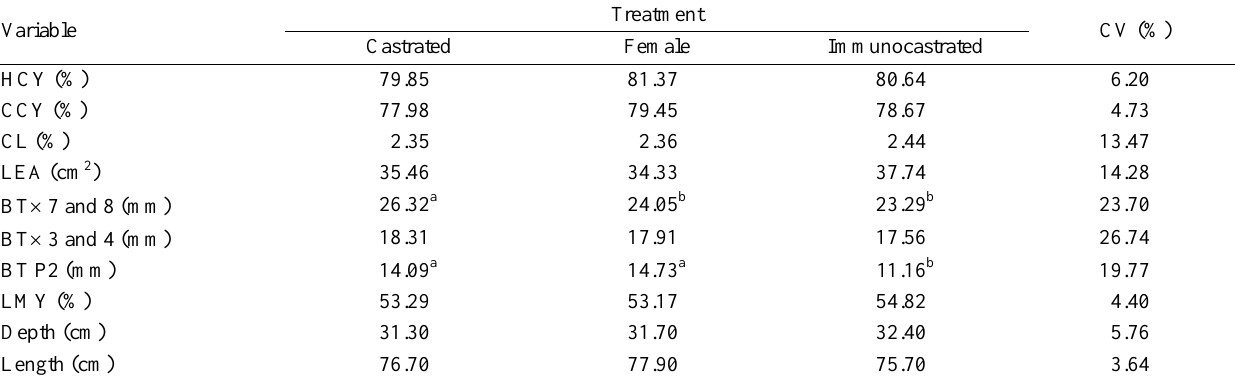
Table 2. Hot carcass yield (HCY), cold carcass yield (CCY), cooling loss (CL), loin eye area (LEA), backfat thickness between the 7th and 8th thoracic vertebra (BT  7 and 8), backfat thickness between the 3rd and 4th lumbar vertebra (BT  3 and 4), backfat thickness at point P2 (BT P2), lean meat yield (LMY), length and depth of carcass from male immunocastrated, surgical castrated and female pigs